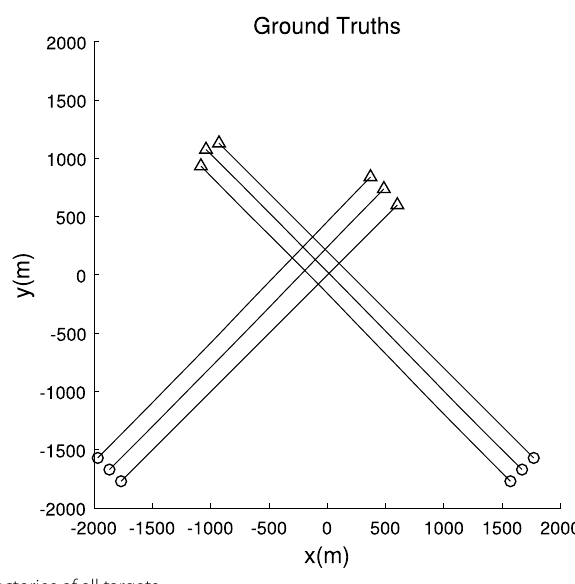
Fig. 12 True trajectories of all